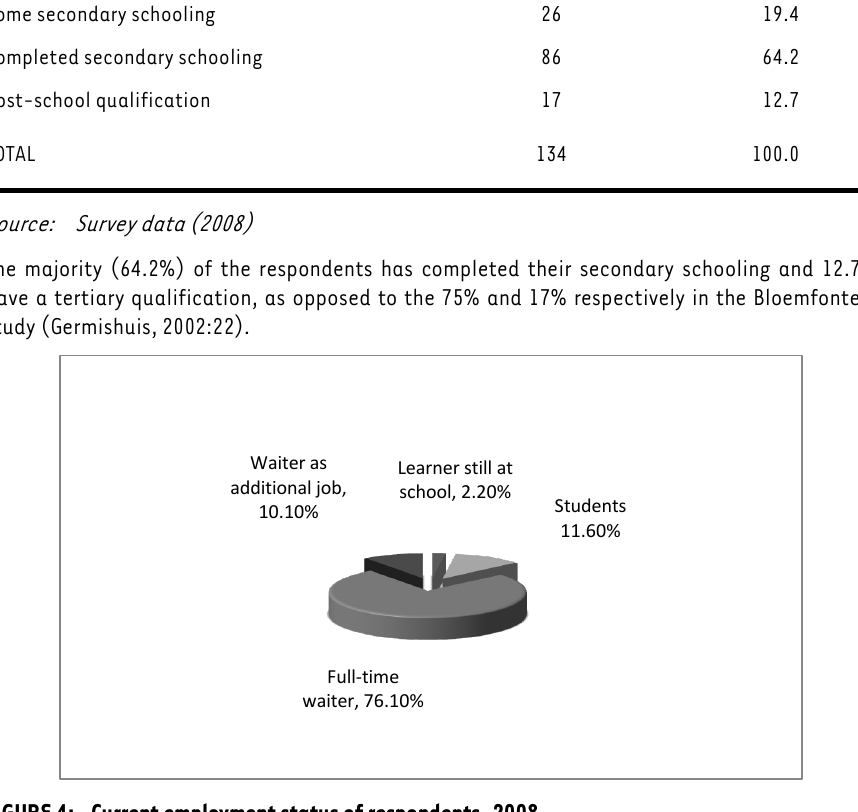
FIGURE 4: Current employment status of respondents, 2008 Source: Survey data